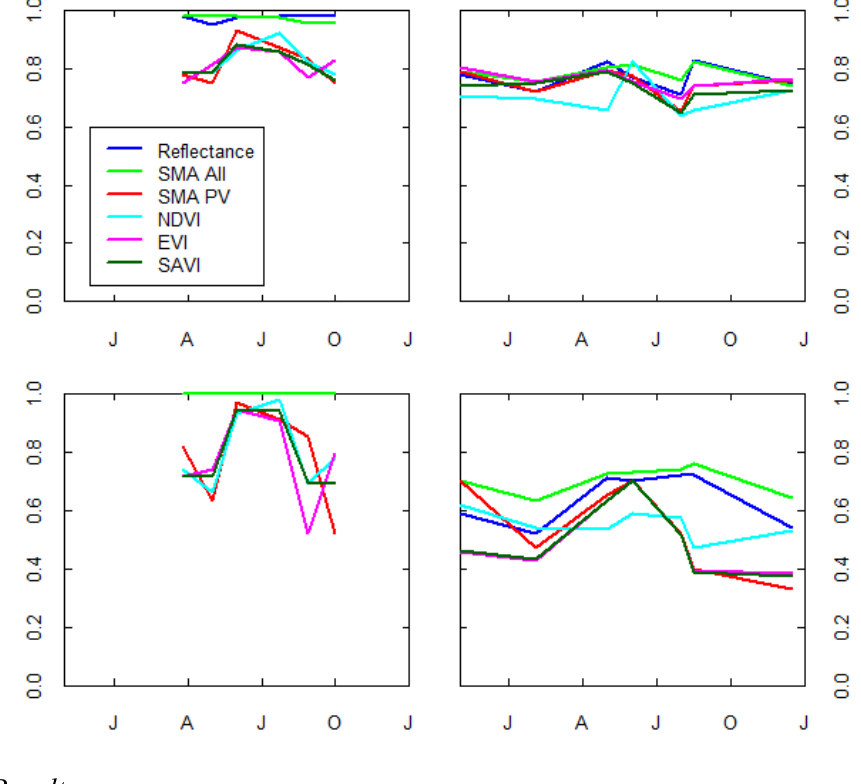
Figure 9. Classification and regression tree (CART) classification accuracy (top row) and AUC values of logistic regression model (bottom) of simulated Landsat TM scenes (left column) and real Landsat TM scenes (right column). The classifications were based on the original 6 Landsat TM bands (Reflectance), the Spectral mixture analysis (SMA)-derived fractions of Photosynthetic vegetation (PV), non-photosynthetic vegetation (NPV), and NPV (SMA All), the SMA-derived fraction of vegetation (SMA Vegetation), and the vegetation indices, Normalized Vegetation Difference Index (NDVI), Enhanced Vegetation Index (EVI), and Soil-adjusted Vegetation Index (SAVI). The baseline y-axis values for accuracy have been shifted to 0.5 to show greater detail. A grey line on the AUC plots denote the 0.5 line, which represents the point where models are no better than